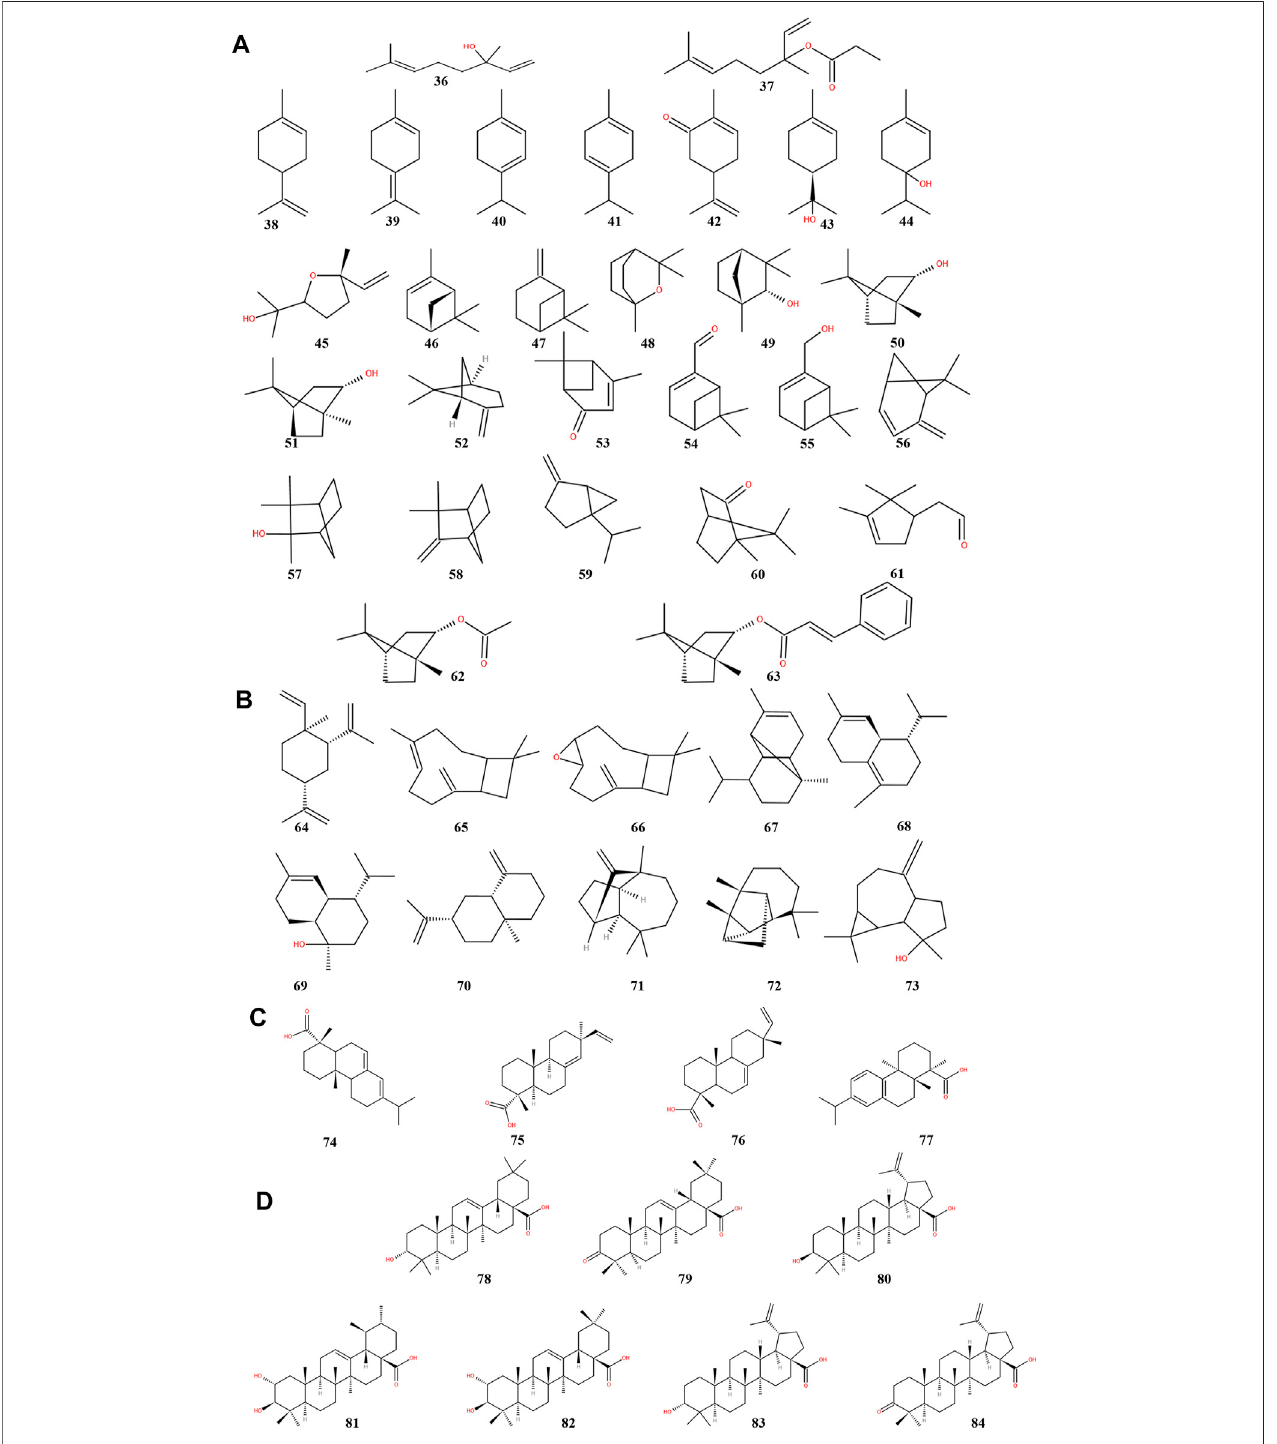
FIGURE 4 | Chemical structures of terpenoids from storax. Monoterpenoids (A) , sesquiterpenoids (B) , diterpenoids (C) and pentacyclic triterpenoids (D) .